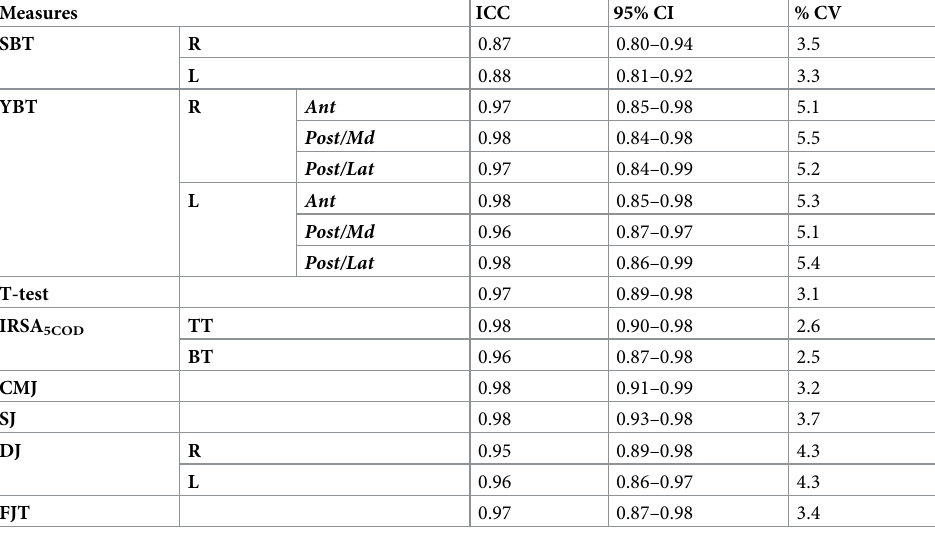
Table 3. Intraclass correlation coefficients (ICCs) for relative reliability and coefficients of variation for absolute reliability of the applied physical fitness